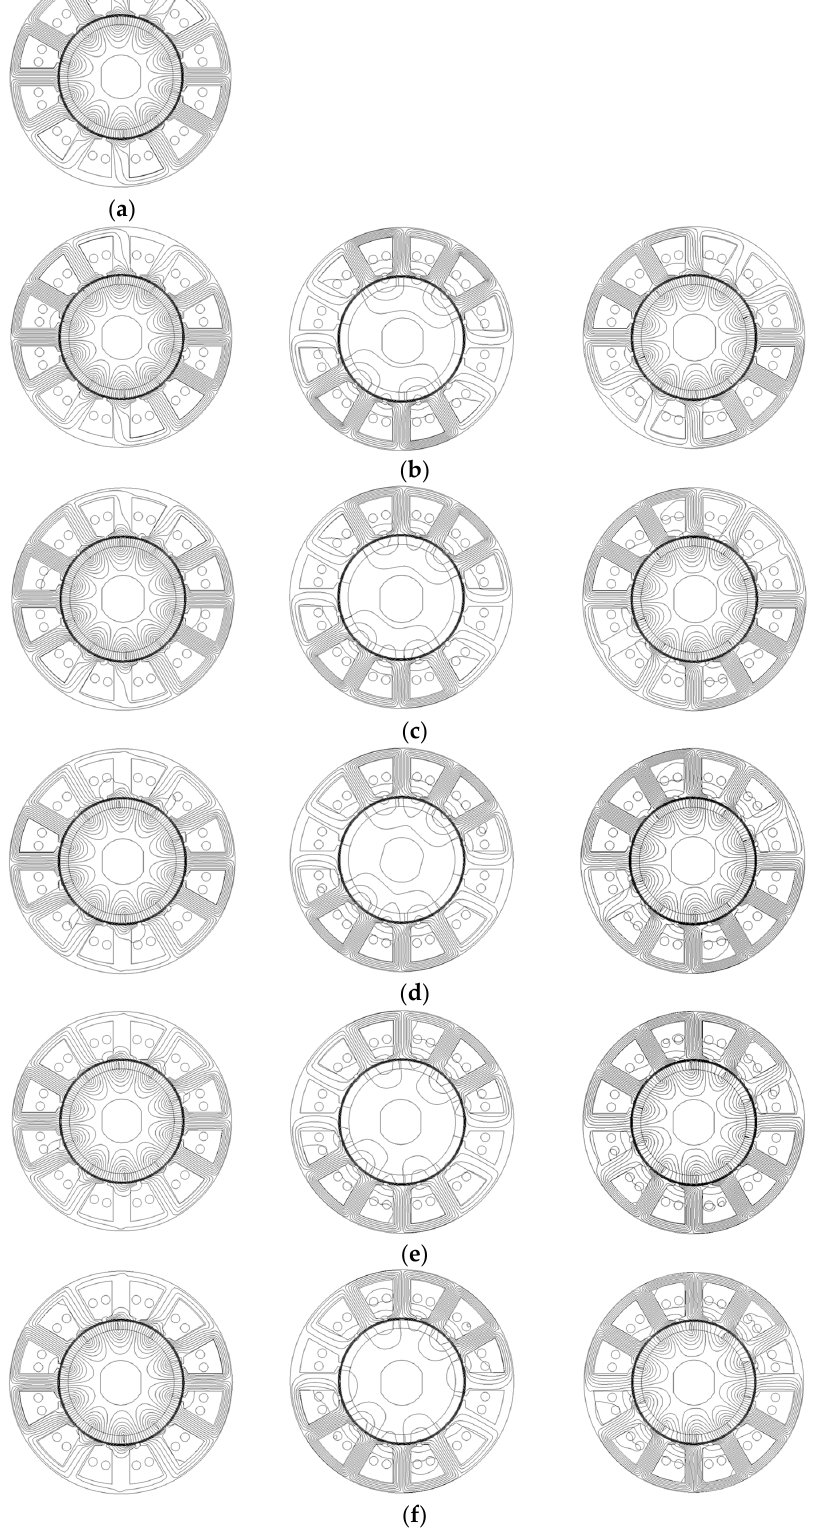
Figure 8. Equal potential distributions for 12s10p-SPM. (from left to right: PM only, armature current only, overall) ( a ) 0A. ( b ) 10A ( c ) 20A. ( d ) 30A. ( e ) 40A. ( f ) 50A.